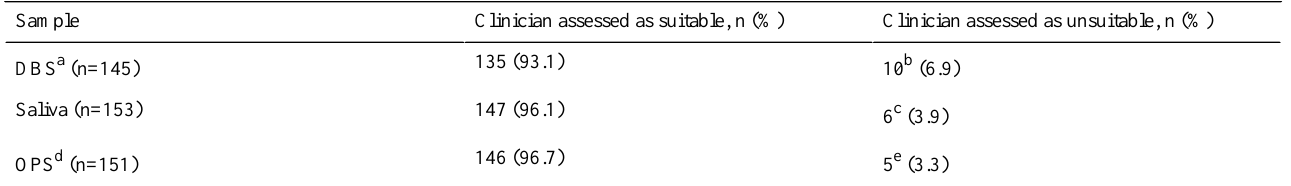
Table 3. Numbers of samples assessed as suitable and unsuitable for laboratory testing.